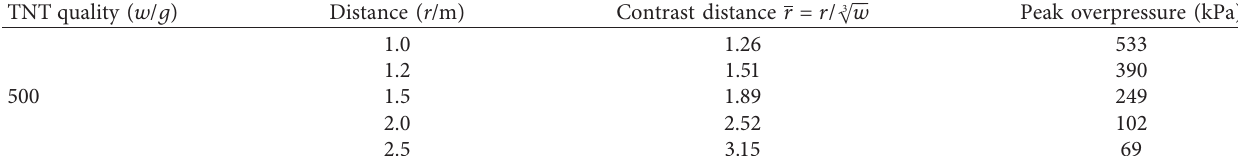
Table 2: Peak overpressures of 500g TNT blast.